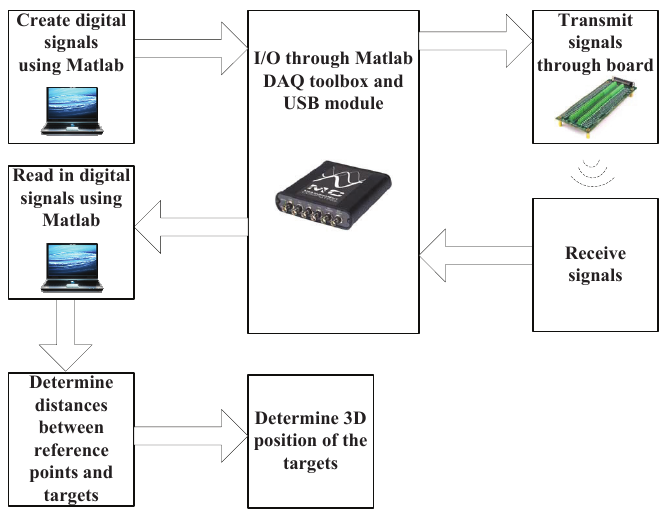
Figure 5. Experimental setup: ( a ) configuration of reference plane; and ( b ) targets.